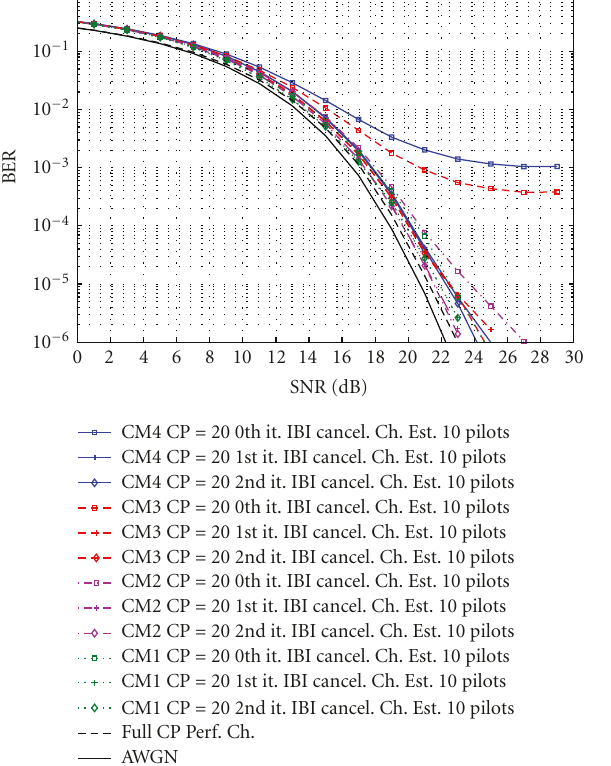
Figure 6: Receiver performance over di ff erent channel models, for CP = 20 and channel estimation with 10 pilot